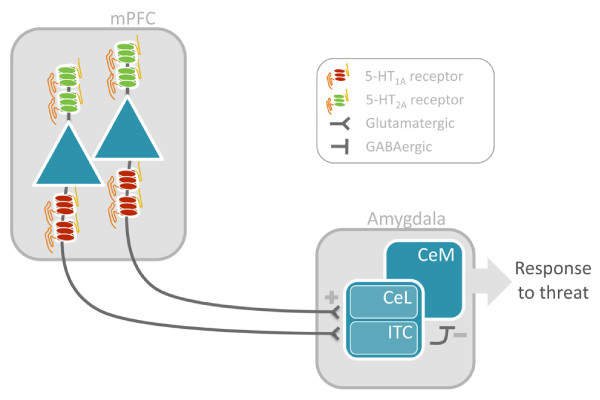
Schematic illustrating mPFC projection neurons that act to regulate amygdala response to threat-related stimuli. 5-HT1A and 5-HT2A in mPFC are positioned to modulate this circuitry by biasing excitability of these mPFC neurons, thereby affecting the capacity to regulate amygdala reactivity. 5-HT = serotonin; mPFC = medial prefrontal cortex; CeL = lateral central nucleus of the amygdala; CeM = medial central nucleus of the amygdala; ITC = intercalated cells.